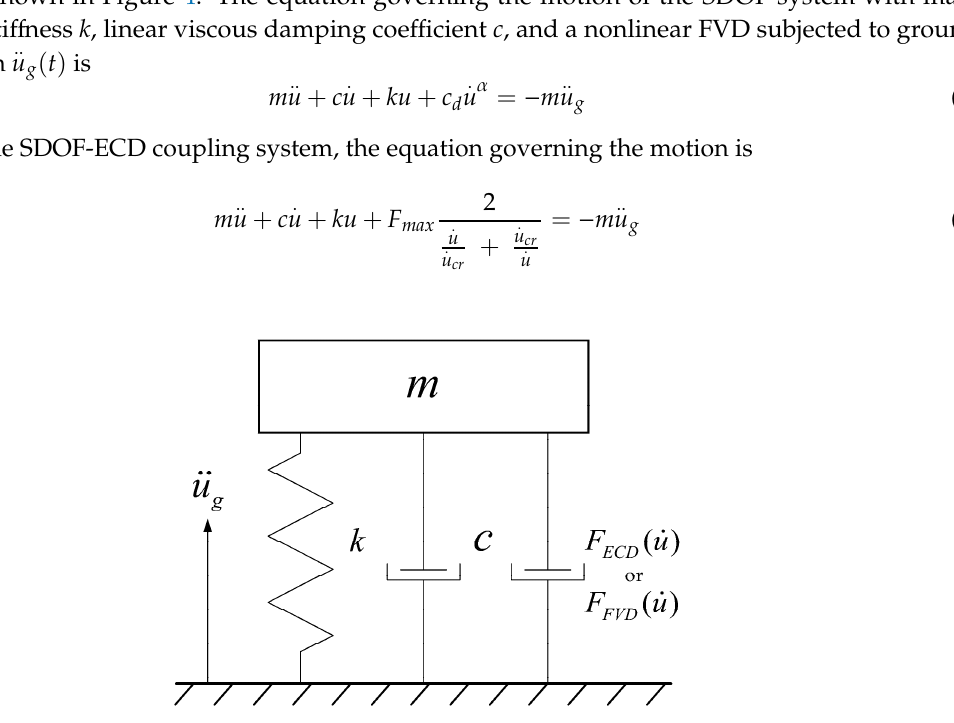
Figure 4. The schematic model of the SDOF system with a supplemental damper subjected to ground